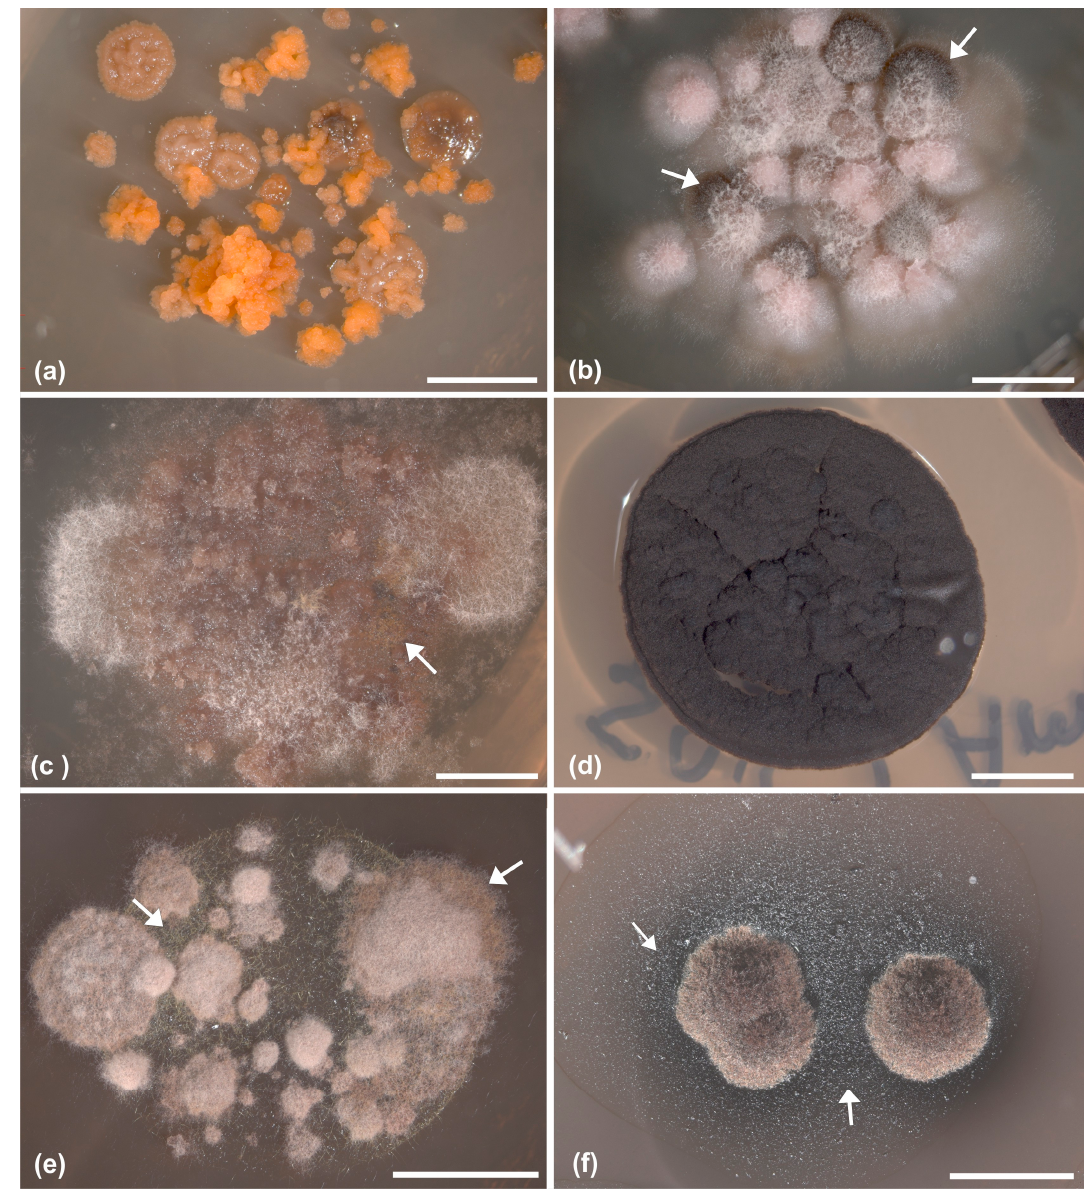
Figure 3. Habit of representative fungal strains which develop peculiar phenotypes of secondary metabolites on diverse culture media (the acronym of medium name and the number of the strain are reported in parentheses): ( a , b , d ) Eurotiomycetes (Chaetothyriales, A1109, A1165 and A527) fungi (on MY and SAB); ( c , e ) Dothideomycetes fungi (on DG18; A1086 and A1168); ( f ) lichen mycobiont Tephromela atra (on LBM, A1180). ( a ) Two different strains with diverse phenotypes have grown out from a single inoculum. ( d ) Chaetothyrialean black fungi (A527) have been the most commonly isolated strains from rock inhabiting lichens. Arrows indicates the areas of the mycelia ( b , c , e ) or of the medium ( f ) where secondary metabolites accumulate and deserve further analyses. Scale bars = ( a – d , f ) 4 mm, ( e ) 5 mm.